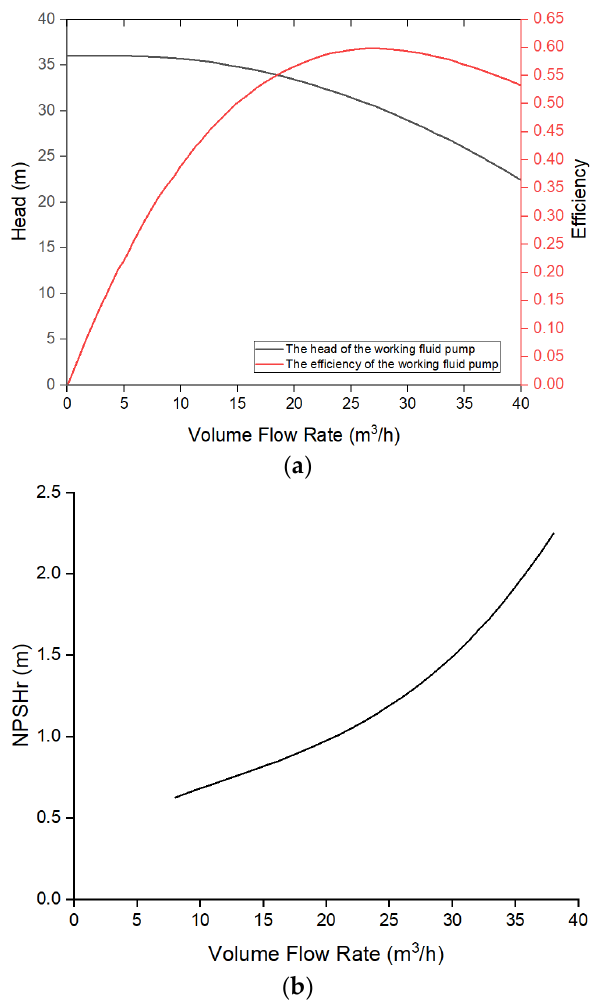
Figure 4. The characteristic curve of the working fluid pump. ( a ) Head and Efficiency vs. Volume Flow Rate. ( b ) NPSHr vs. Volume Flow